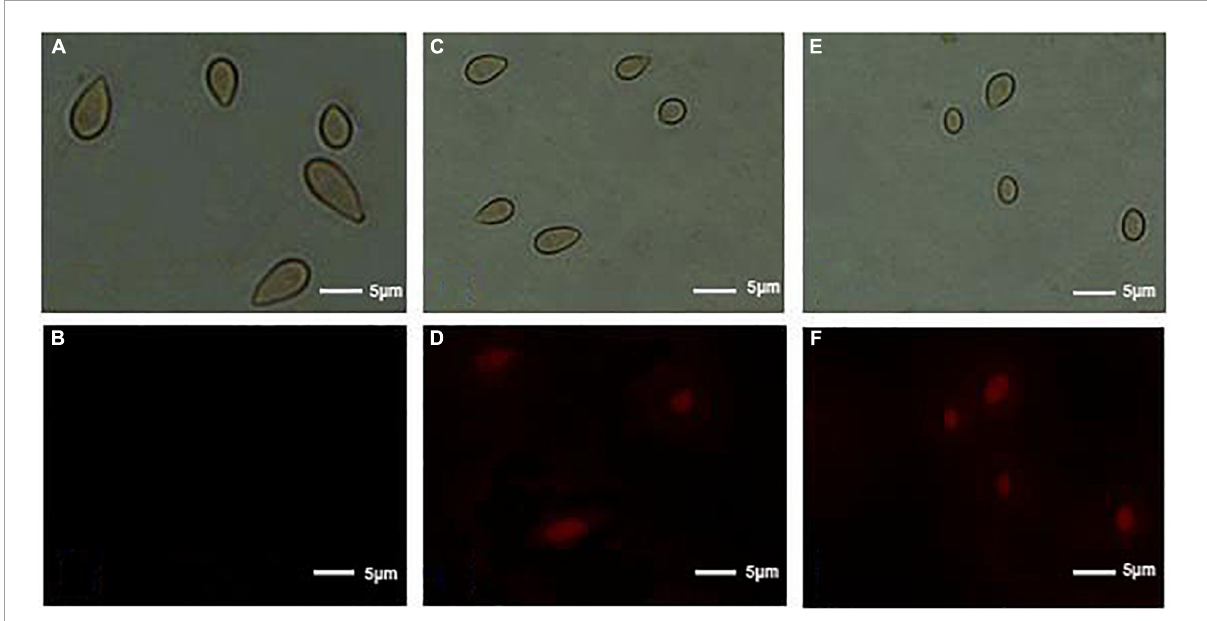
FIGURE3 Effect of control, 8 × MFC, and 16 × MFC (E)-2-hexenal on the membrane integrity of B. cinerea spores. Spores were cultured at 28 + 2 ◦ C in PDB medium supplemented with 0 ( A, bright field; B, PI) or 8 × MFC ( C, bright field; D, PI), and 16 × MFC ( E, bright field; F, PI) for 2 h of incubation, and spores were stained with the PI and observed with a fluorescence microscope. The scale bar indicated the length of 5 µ m.